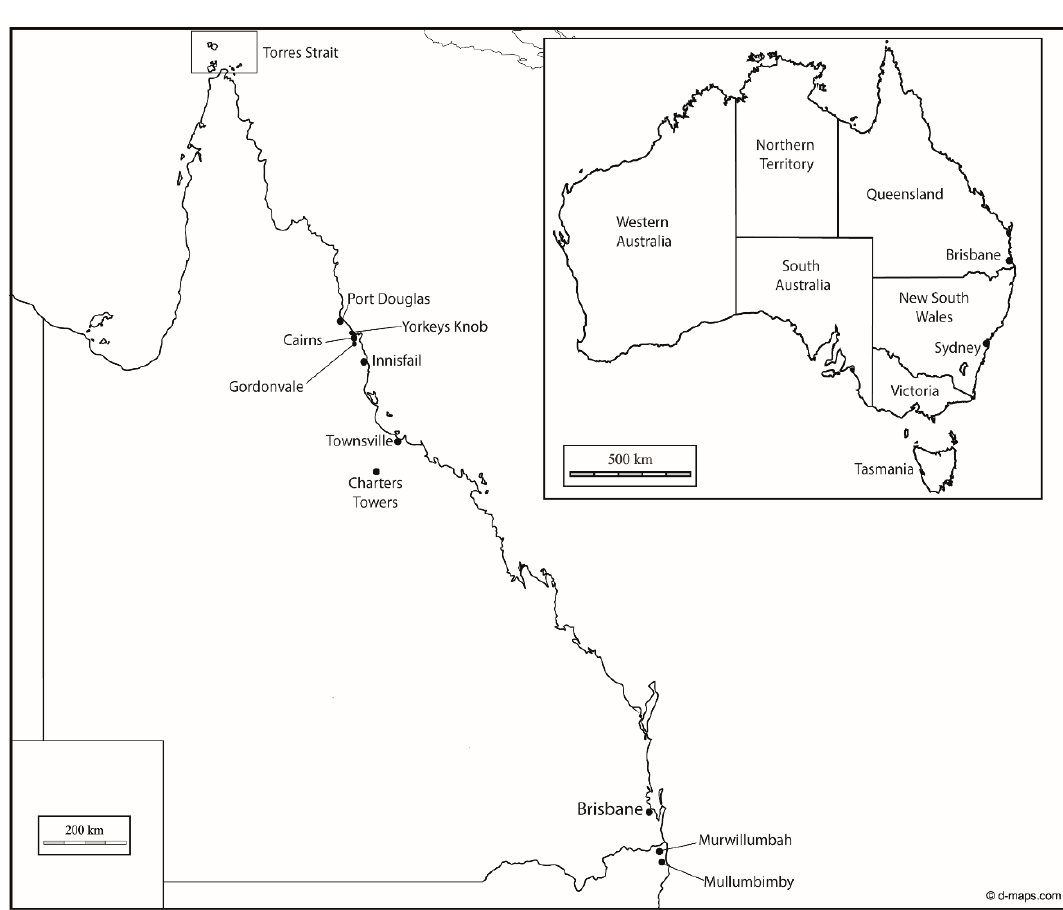
Figure 1. Map of Australia (inset) and Queensland, showing locations mentioned in the text.